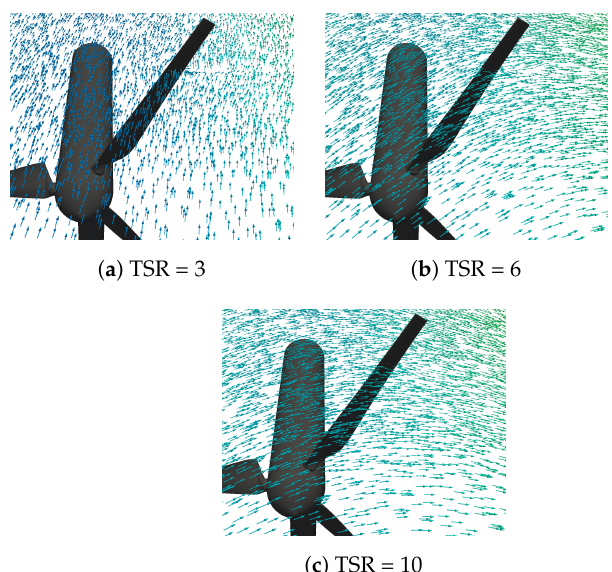
Figure 12. HAWT-S826: Comparison of flow-patterns for Case-IV at TSR values of 3, 6 and 10. At TSR of 3 the turbine operates in stall mode and TSR of 6 corresponds to the design condition, with the flow streamlined in direction to the blade. The flow becomes parallel to the plane of rotation at TSR of